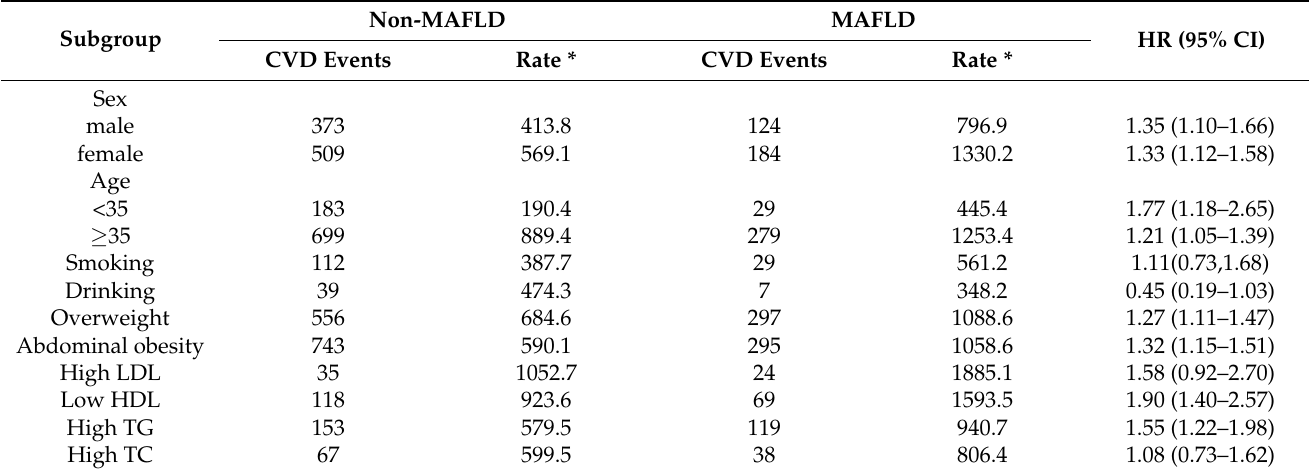
Table 3. Subgroup analysis of the relationship between metabolic dysfunction-associated fatty liver disease and cardiovascular disease.